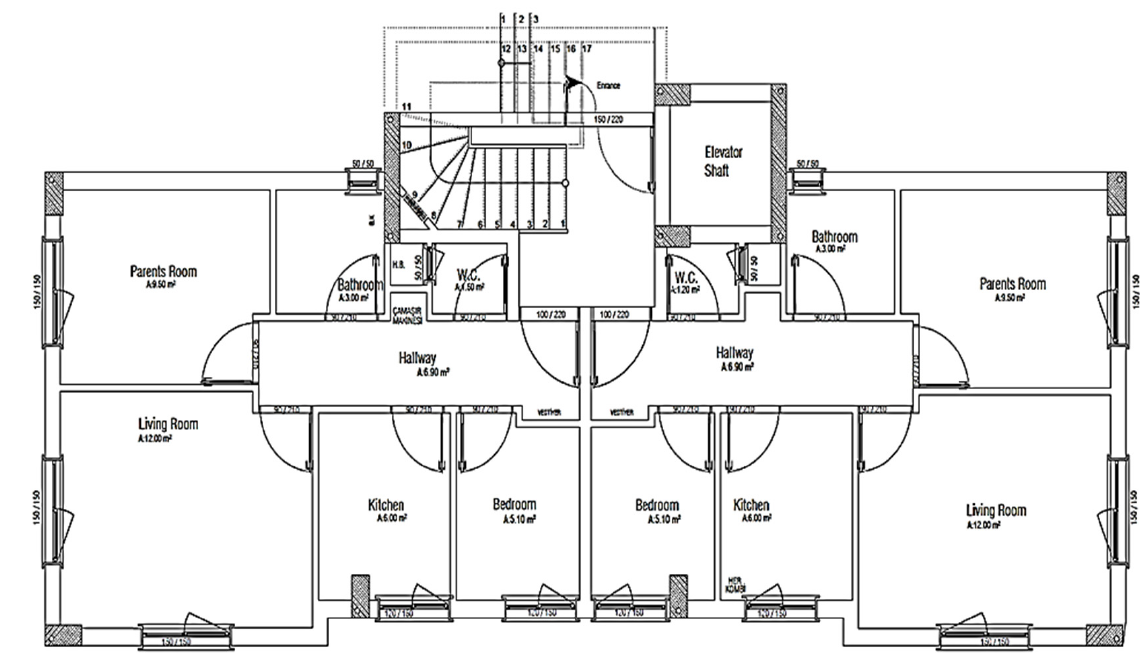
Figure 7. The first story plan of studied building. Table 3. Structure of building envelope components.